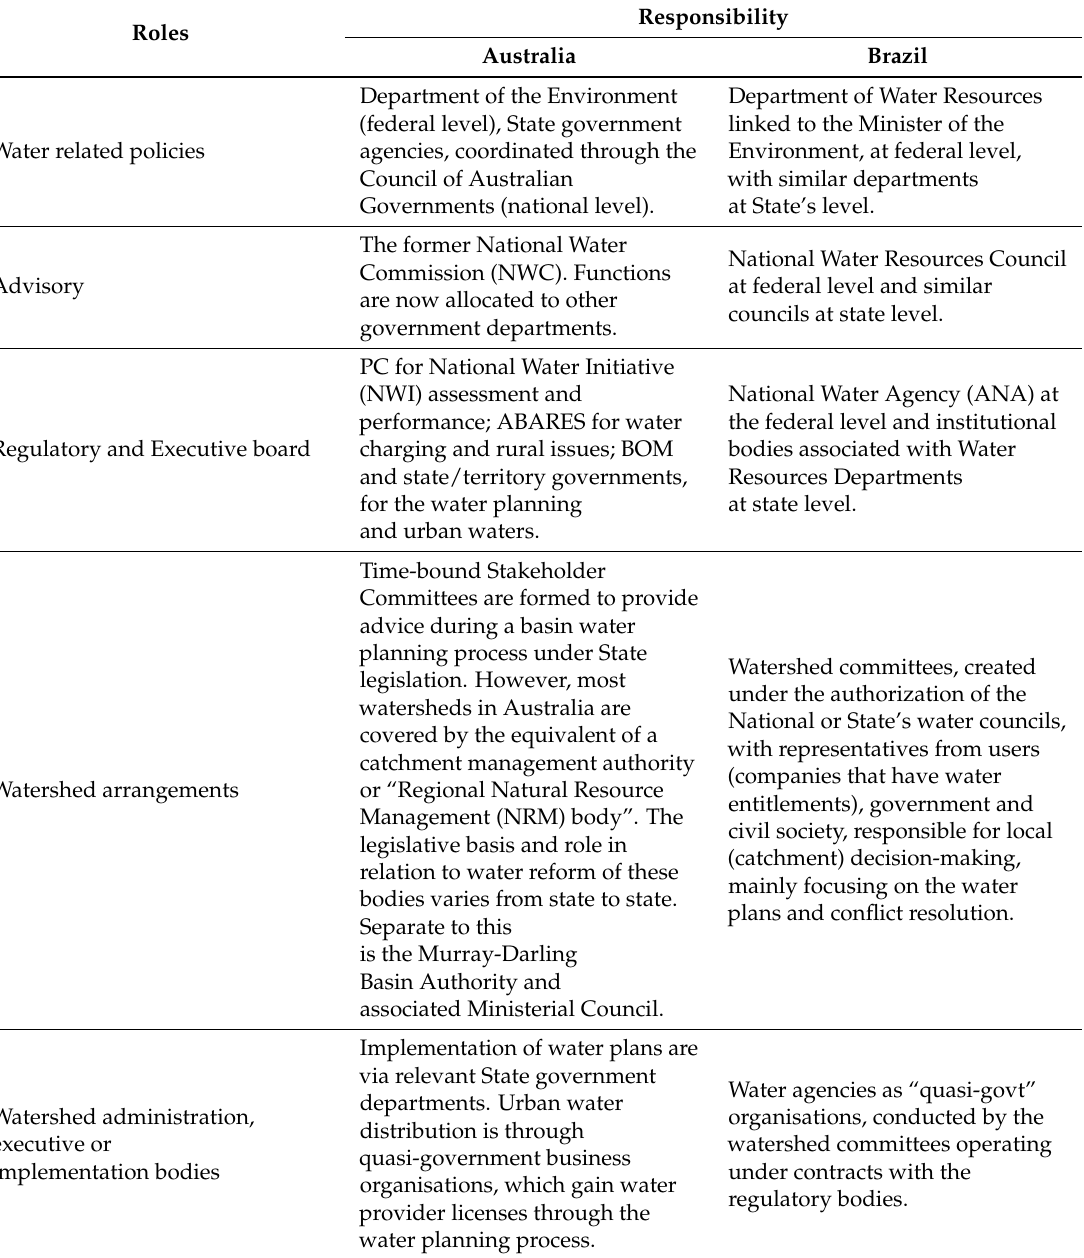
Table 1. Roles and responsibilities for water resources management in Australia and